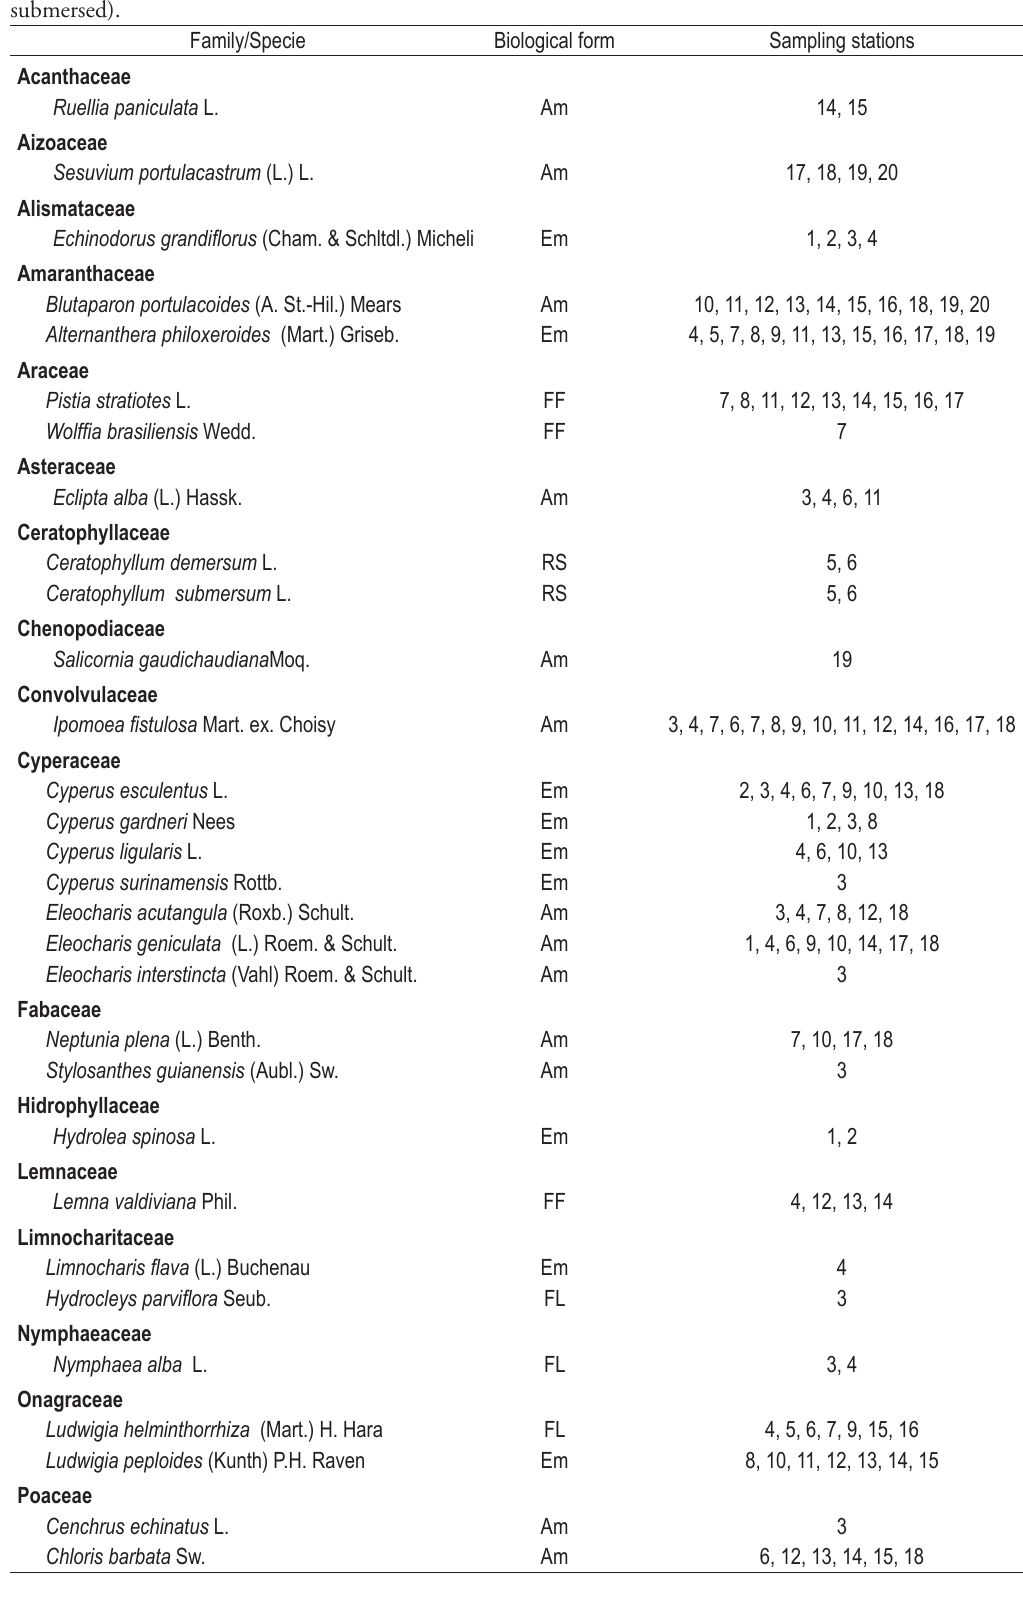
Table 1. List of occurrences of species in hydrographic basin of the Apodi/Mossoró River, RN, Northeast Brazil. (Biological forms: Am = Amphibian, Em = Emergent, FL = Floating leaved, FF = Free-floating, RS = Rooted